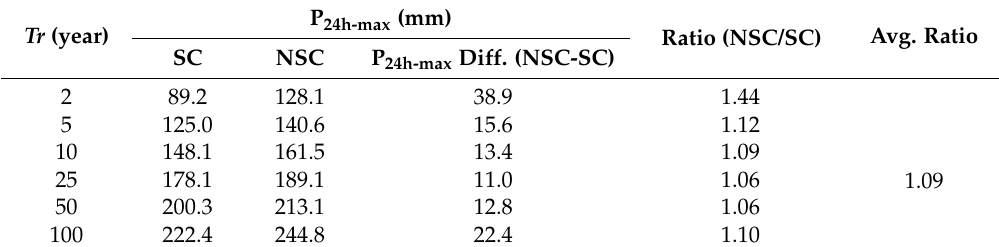
Table 10. P 24h-max values